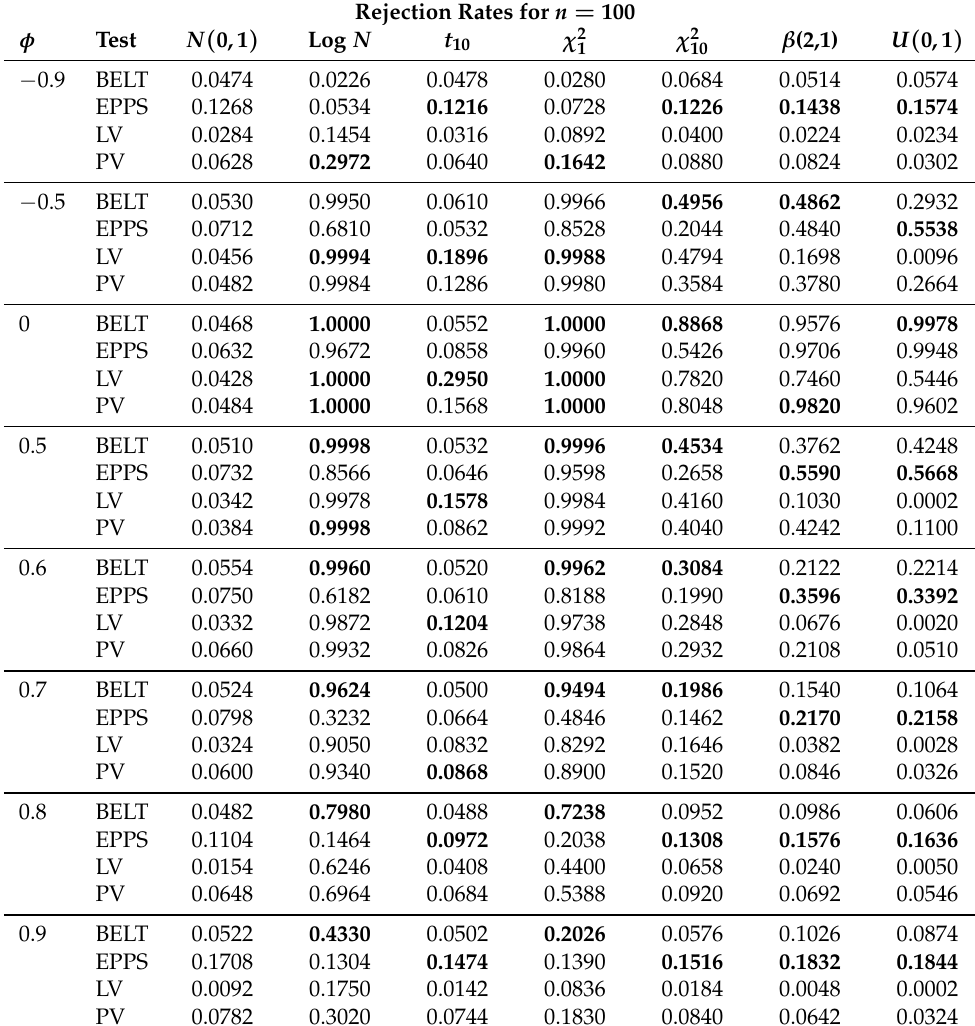
Table 4. Empirical rejection probabilities of the process defined in (10) at the 0.05 nominal level for n = 100 using 5000